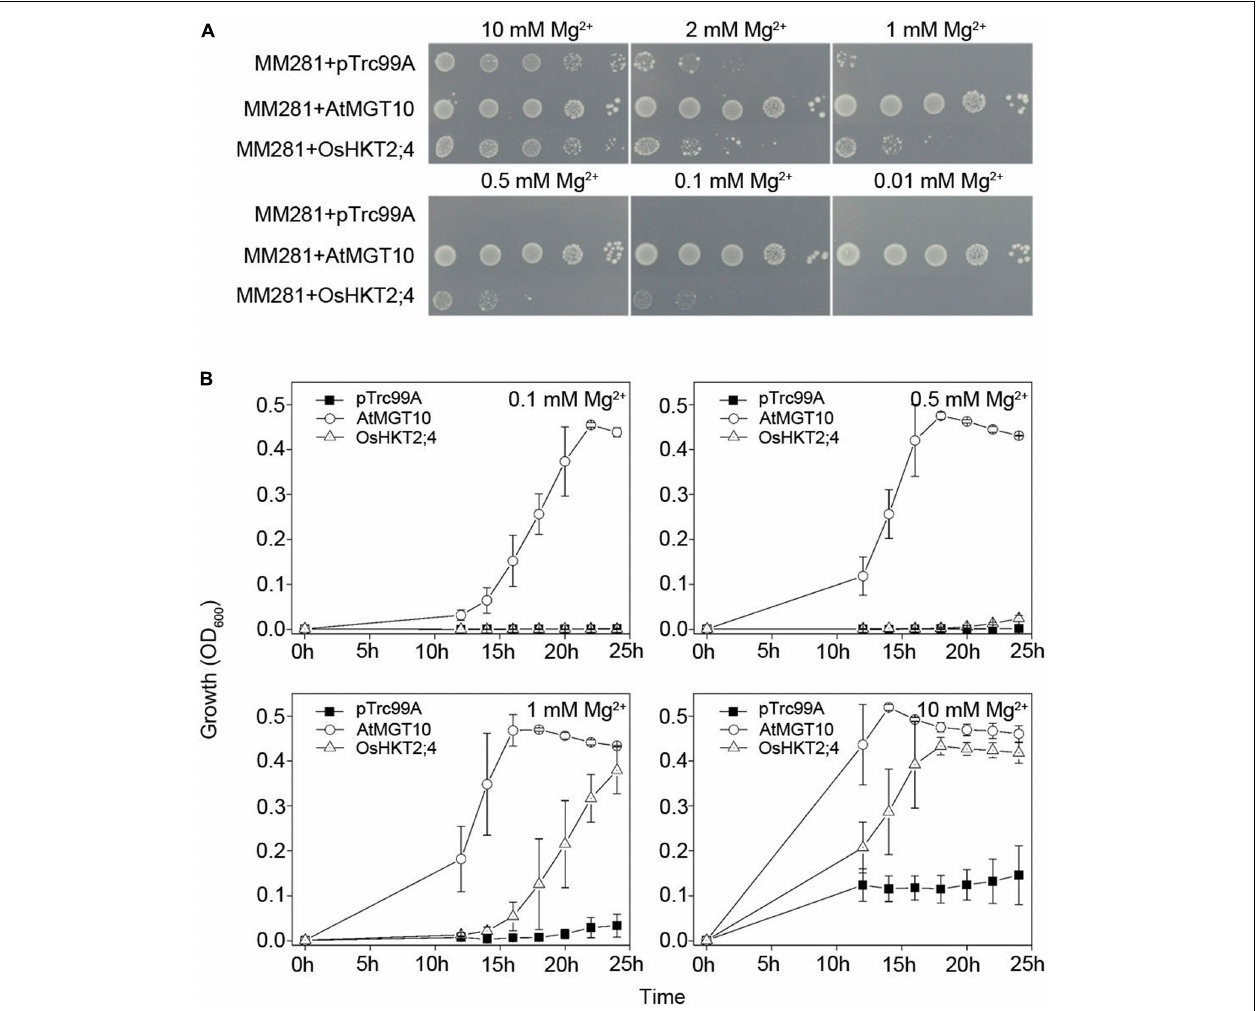
FIGURE 1 | Complementation of growth defects of bacterial mutant strains MM281 by OsHKT2;4 under the low-Mg 2 + conditions. (A) Growth of bacterial strains on N-minimal medium containing 0.01, 0.1, 0.5, 1, 2, or 10 mM Mg 2 + . The strains used in this assay were the strains MM281 transformed with the empty pTrc99A vector only (MM281+pTrc99A), coding sequence of MGT10 in the pTrc99A vector (MM281+MGT10), or coding sequence of OsHKT2;4 in pTrc99A vector (MM281+OsHKT2;4). From left to right is a 10-fold dilution series of bacterial cultures. (B) Growth curves of bacterial strains in liquid cultures. Bacterial cells described in (A) were grown in N-minimal liquid medium containing increasing concentrations of Mg 2 + from 0.1 to 10 mM. Aliquots of the cultures were taken and monitored every 2 h by OD 600 readings for the cell density from 10 to 24 h. Data are represented as the mean ± SD, n = 3.